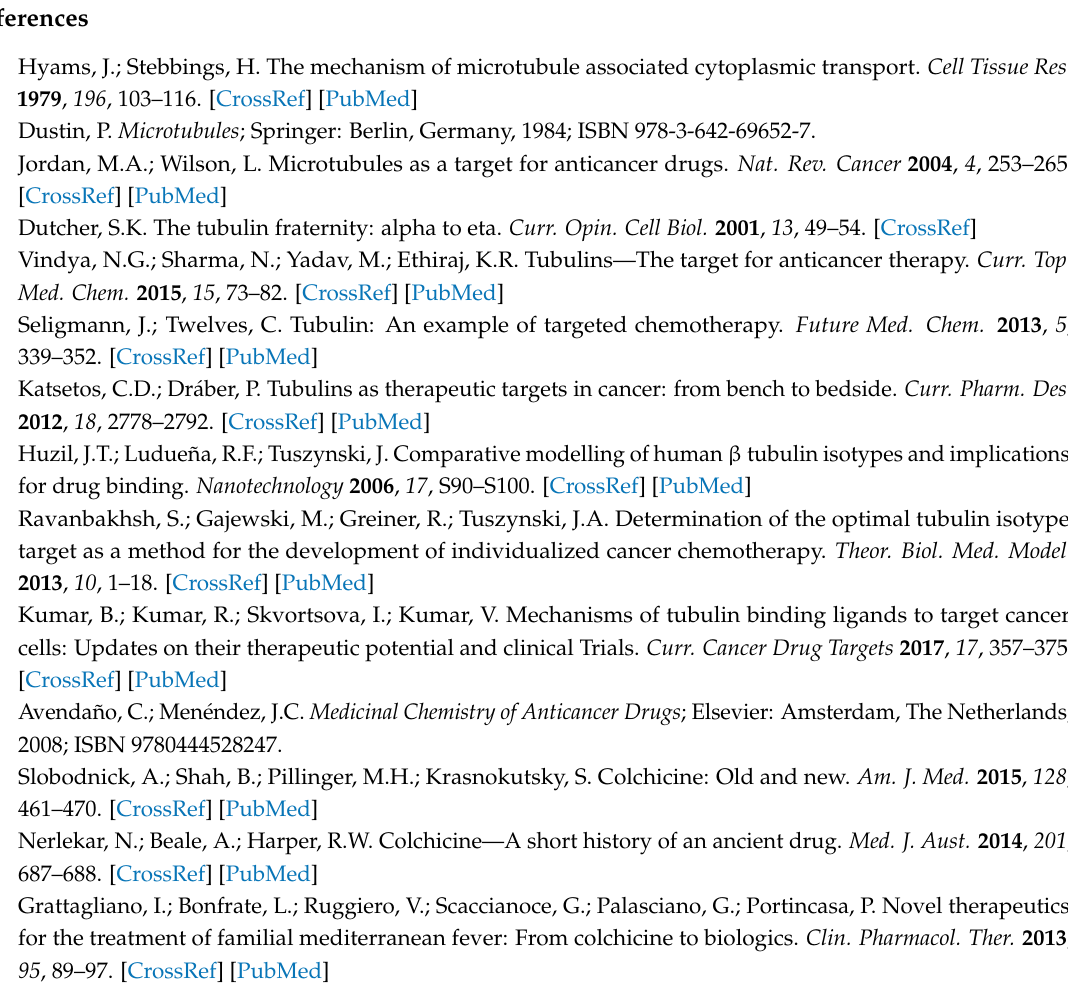
Supplementary Materials: The following are available online, Figure S1: The 13 C-NMR spectrum of 2 in CDCl 3 , Figure S2: The 1 H-NMR spectrum of 2 in CDCl 3 , Figure S3: The 13 C-NMR spectrum of 3 in CDCl 3 , Figure S4: The 1 H-NMR spectrum of 3 in CDCl 3 , Figure S5: The 13 C-NMR spectrum of 4 in CDCl 3 , Figure S6: The 1 H-NMR spectrum of 4 in CDCl 3 , Figure S7: The 13 C-NMR spectrum of 5 in CDCl 3 , Figure S8: The 1 H-NMR spectrum of 5 in CDCl 3 , Figure S9: The 13 C-NMR spectrum of 6 in CDCl 3 , Figure S10: The 1 H-NMR spectrum of 6 in CDCl 3 , Figure S11: The 13 C-NMR spectrum of 7 in CDCl 3 , Figure S12: The 1 H-NMR spectrum of 7 in CDCl 3 , Figure S13: The 13 C-NMR spectrum of 8 in CDCl 3 , Figure S14: The 1 H-NMR spectrum of 8 in CDCl 3